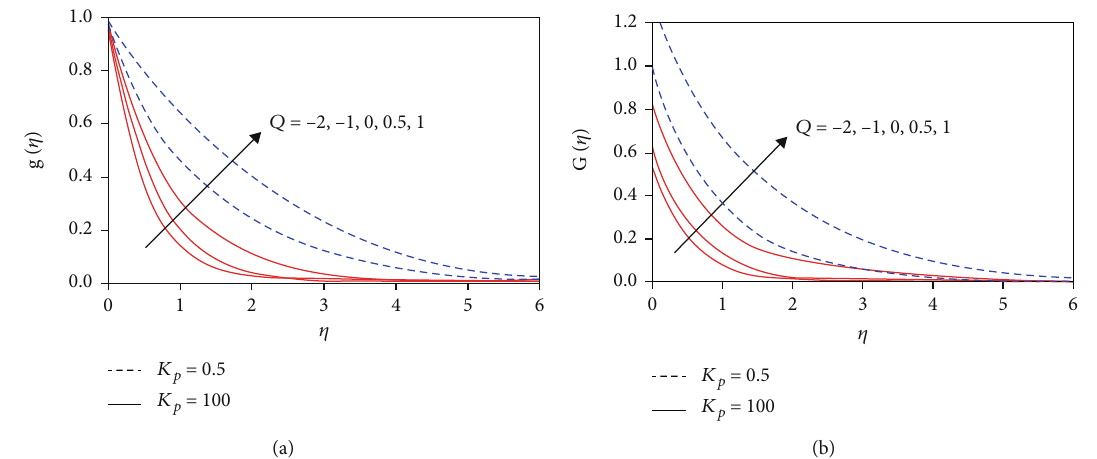
= 0 : 1 and Rc = 0 : 5, and f w = 0 1